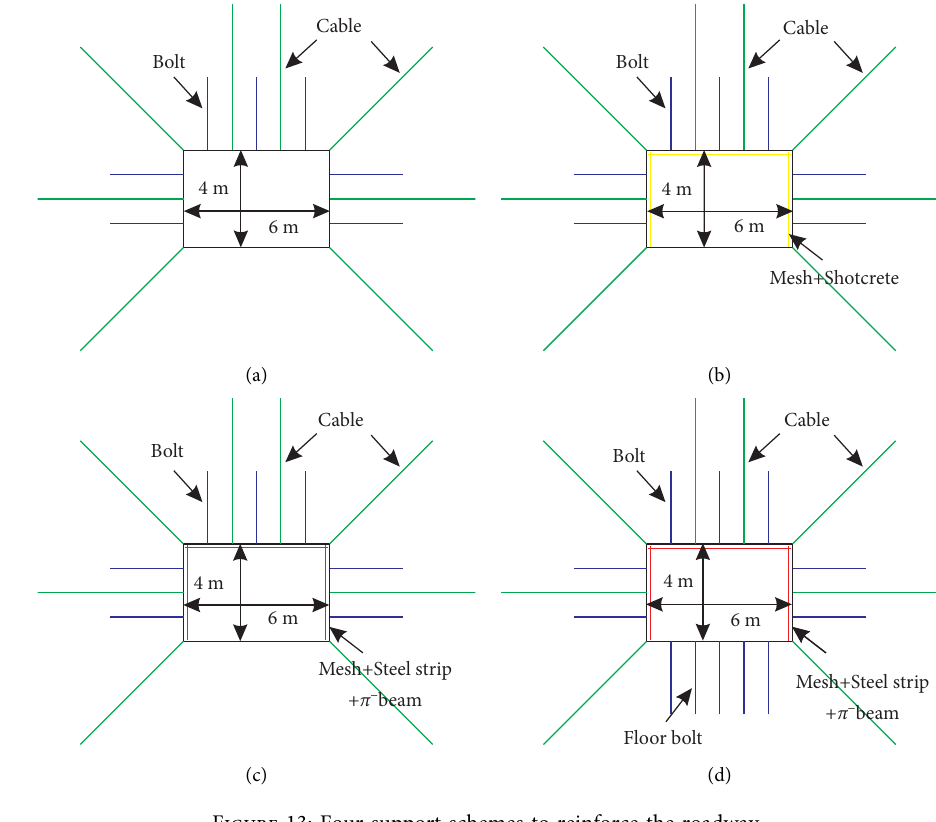
Figure 13: Four support schemes to reinforce the roadway. Table 4: Properties of the bolt and cable elements used in the UDEC.